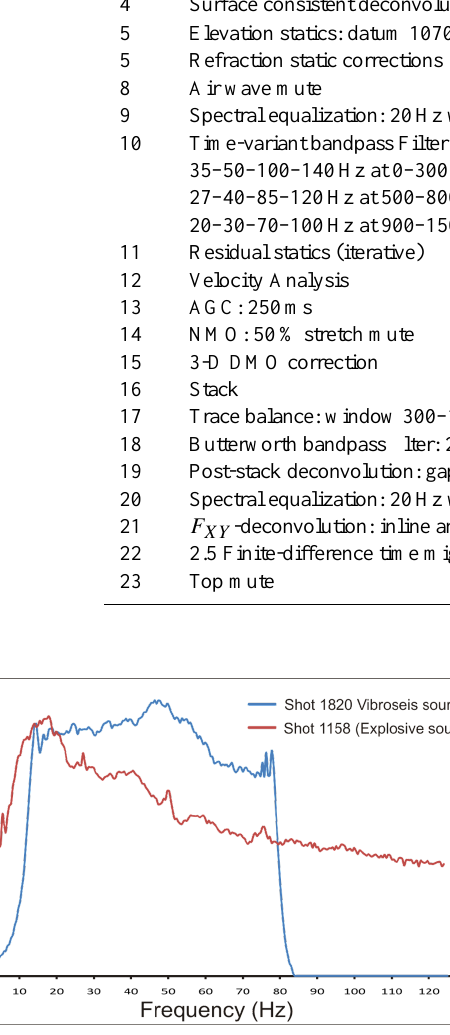
FIG. 5: (a) CDP fold coverage calculated from a CDP bin size of 13 m. (b) Source-receiver Fig. 5. (a) CDP fold coverage calculated from a CDP bin size of offset distribution. (c) Azimuthal coverage of the survey. 13m. (b) Source-receiver offset distribution. (c) Azimuthal cover- age of the